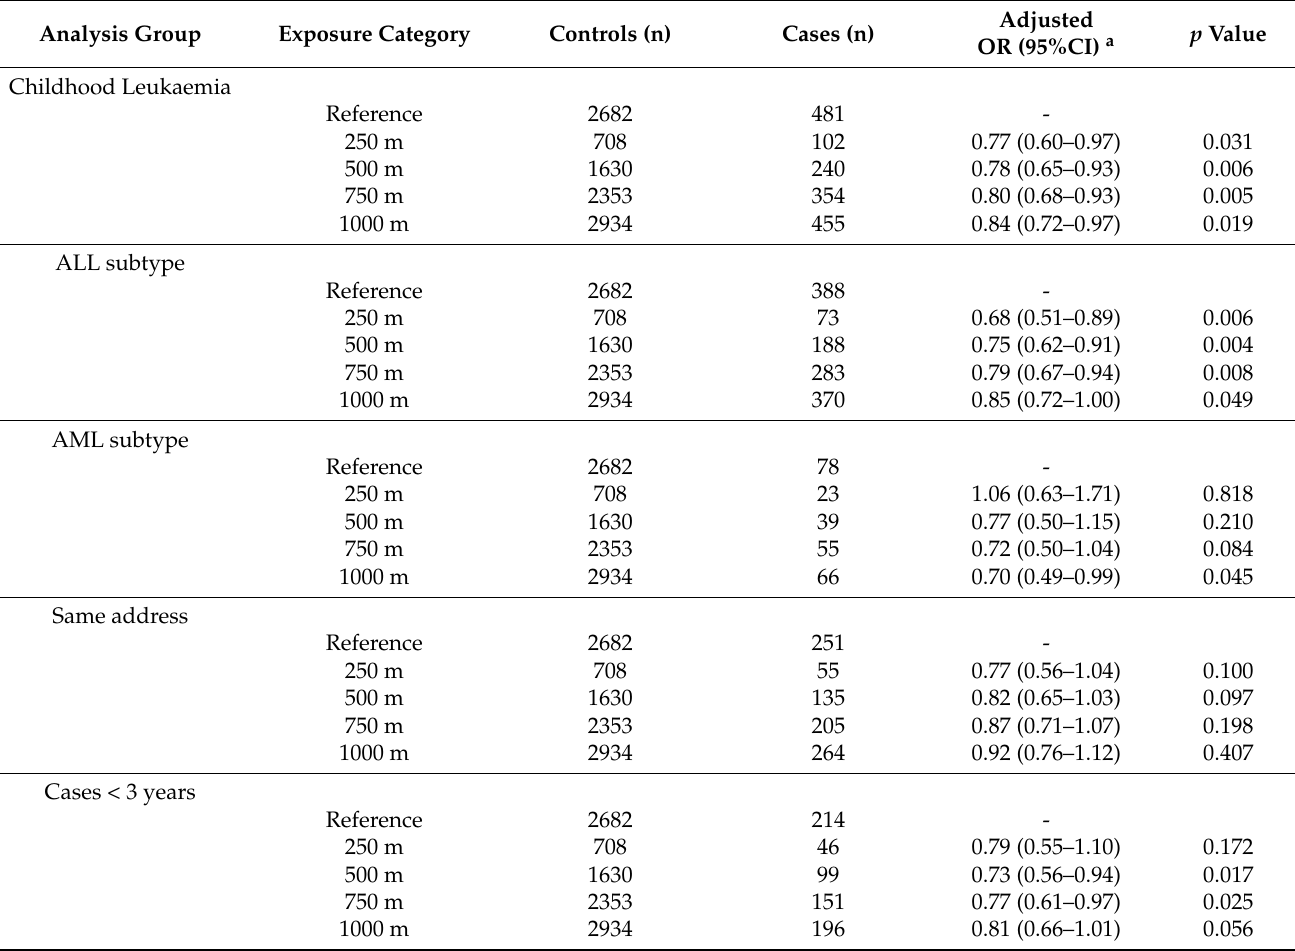
Table 2. Blue-space analysis for overall childhood leukaemia, ALL and AML subtypes, and identified cases with same address at birth and diagnosis results. Adjusted models for sex, birth year, SES, activity rate, DGUR, PM 10 levels, and surrounding